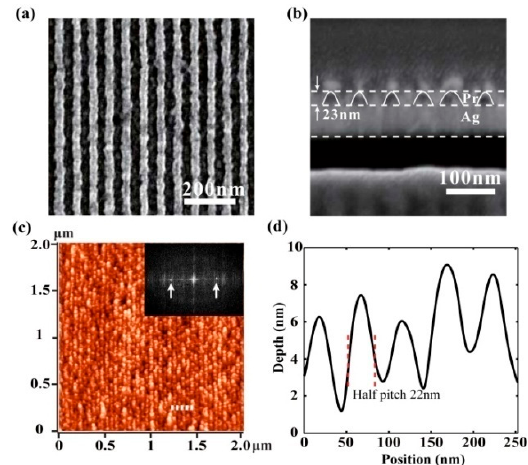
Figure 29. ( a , b ) are the scanning electron microscope (SEM) pictures and cross profile of the resist pattern for half-pitch 32 nm, respectively; ( c , d ) are for half-pitch 22 nm. Inset in (c) is Fourier spectrum distribution. Reproduced from [24], Copyright © 2015, AIP.